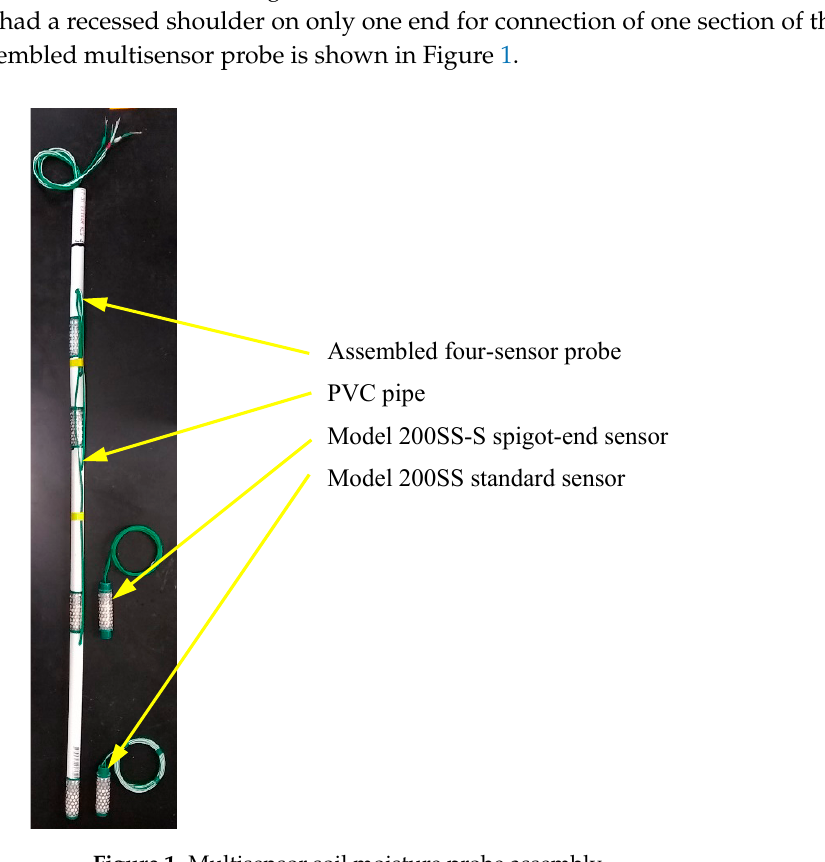
Figure 1. Multisensor soil moisture probe assembly.